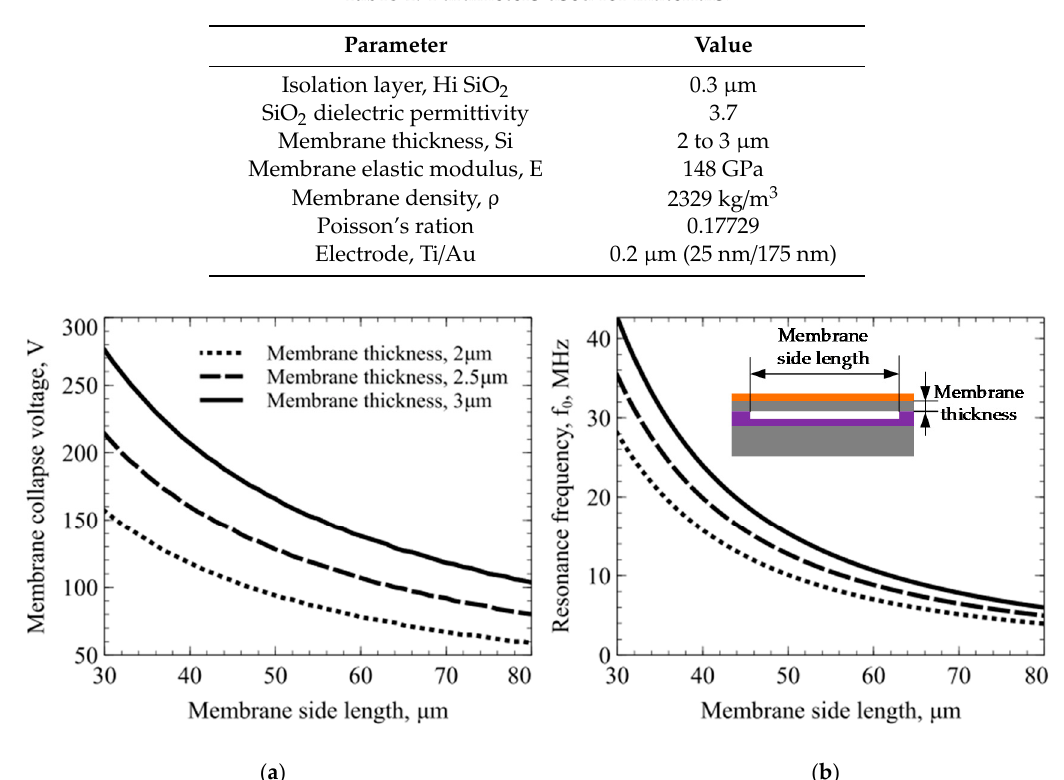
Figure 1. Capacitive micromachined ultrasonic transducer (CMUT) analytical model results: ( a ) membrane collapse voltage as a function of membrane side length and thickness; ( b ) membrane resonance frequency as a function of membrane side length and thickness. A small inset shows the structure of the single CMUT cell and the parameters simulated in the analytical model.